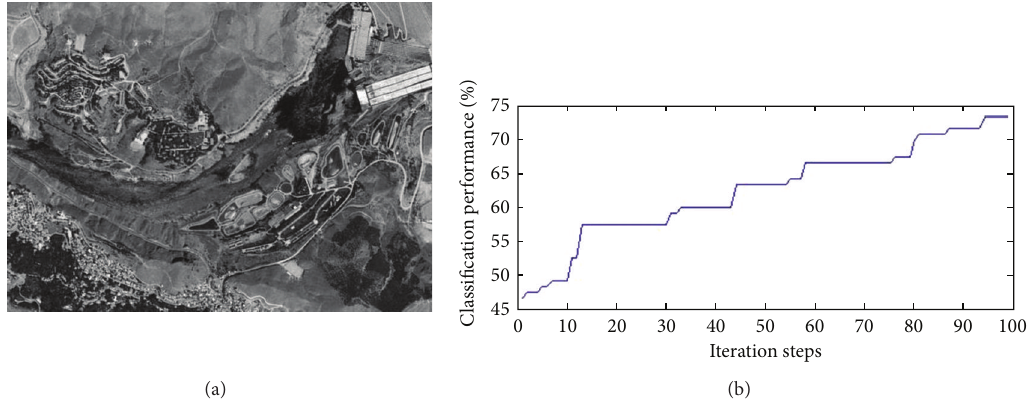
Figure 4: (a) Example remote image ( 400 × 400 pixel). (b) Performance graphic.